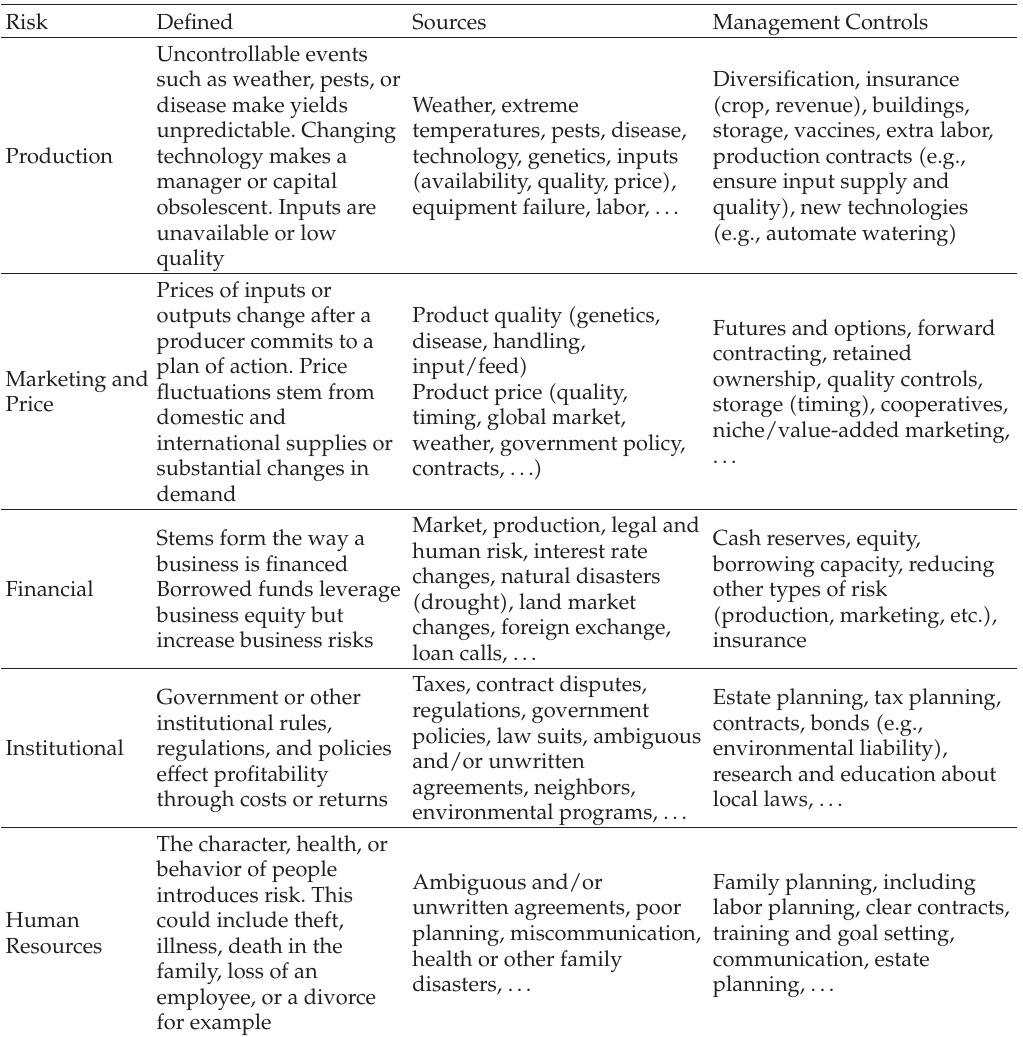
Table 1: Risk management sources and controls; see source in (cid:4) 6 (cid:5)